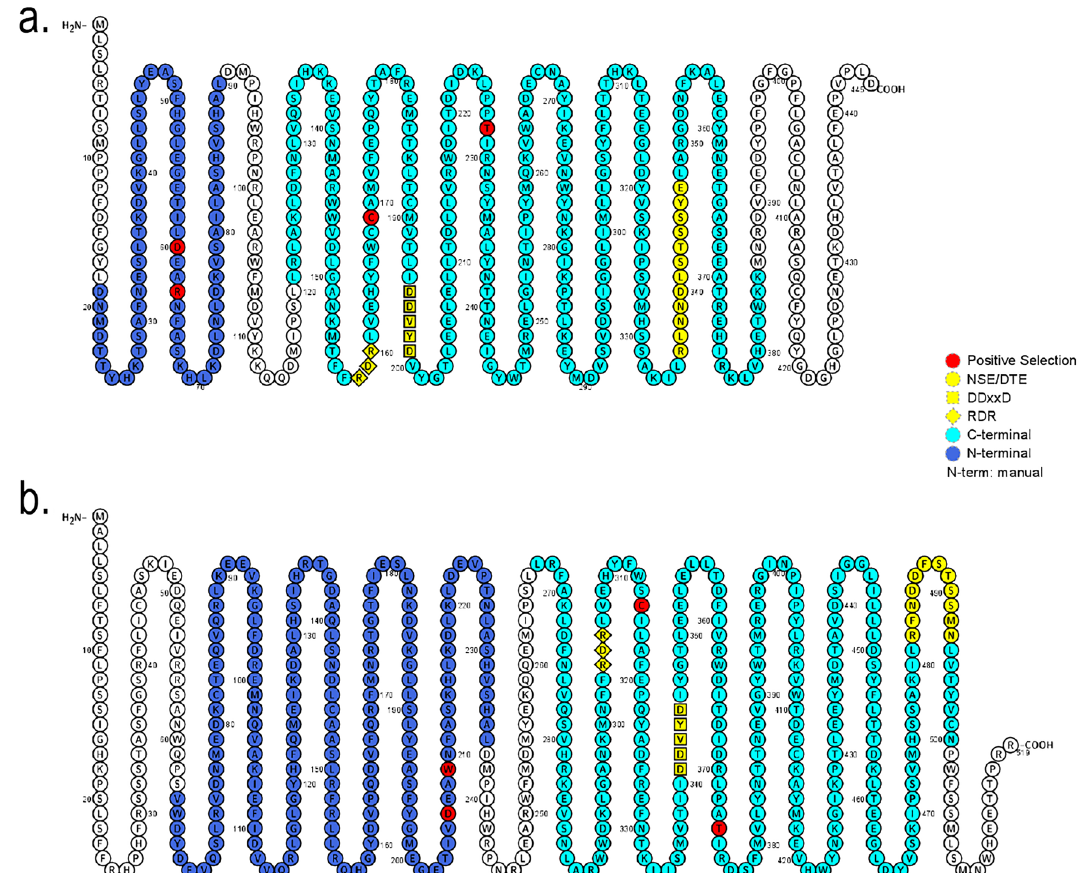
Figure 4. Positive selected sites in TPS-b1 branch including only Psidium genes. ( a ) The pinene synthase sequence Pca_red_g24428 representing clade 2 as foreground clade. ( b ) The linalool synthase sequence Pca_ red_g28382 represents clade 2 as foreground clade. Amino acids that were identified on positive selection (red circles) are demonstrated on the protein sequence of these representative species corresponding to the sites in each alignment presented on Supplementary Table S12. Also, the representation of mainly motifs of the entrance of the active site (yellow square, circles, and triangle) represented for the “DDXXD”, “NSE/DTE” and “RXR”